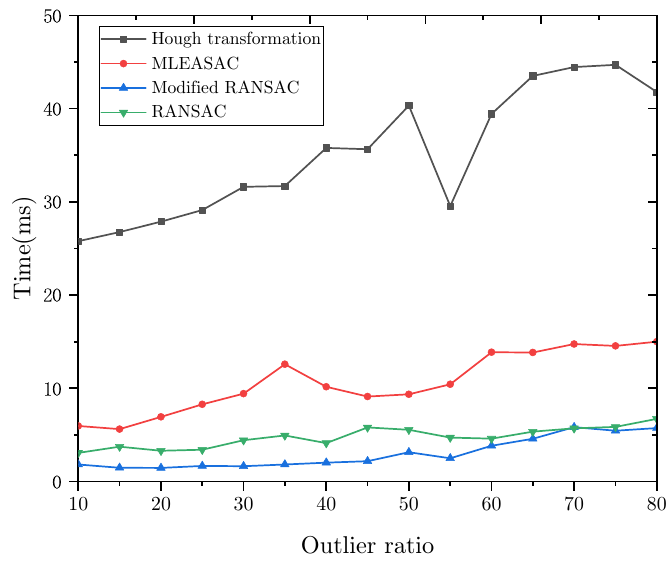
Figure 5. Time consumption vs. the ratio of noisy points.